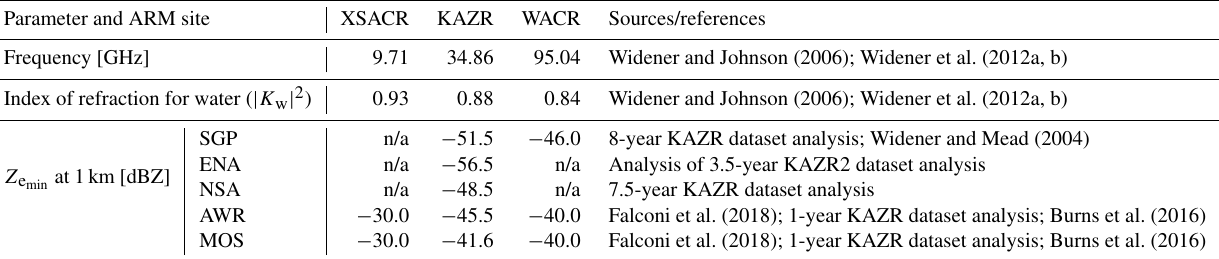
Table 2. Radar instruments and some of their characteristics currently implemented in EMC 2 . The ARM SGP, ENA, NSA, AWR, and MOS site abbreviations denote the Southern Great Plains, Eastern North Atlantic, North Slope of Alaska, the AWARE campaign (at McMurdo Station, Antarctica), and the Multidisciplinary Drifting Observatory for the Study of Arctic Climate (MOSAiC) Expedition, respectively. The calculations of the minimum detectable signal ( Z e ) for KAZR are based on the analysis in Silber et al. (2018a). All Z e values min min correspond to 2s integration time except for the AWR and MOS WACR, the values of which correspond to 0.2s integration